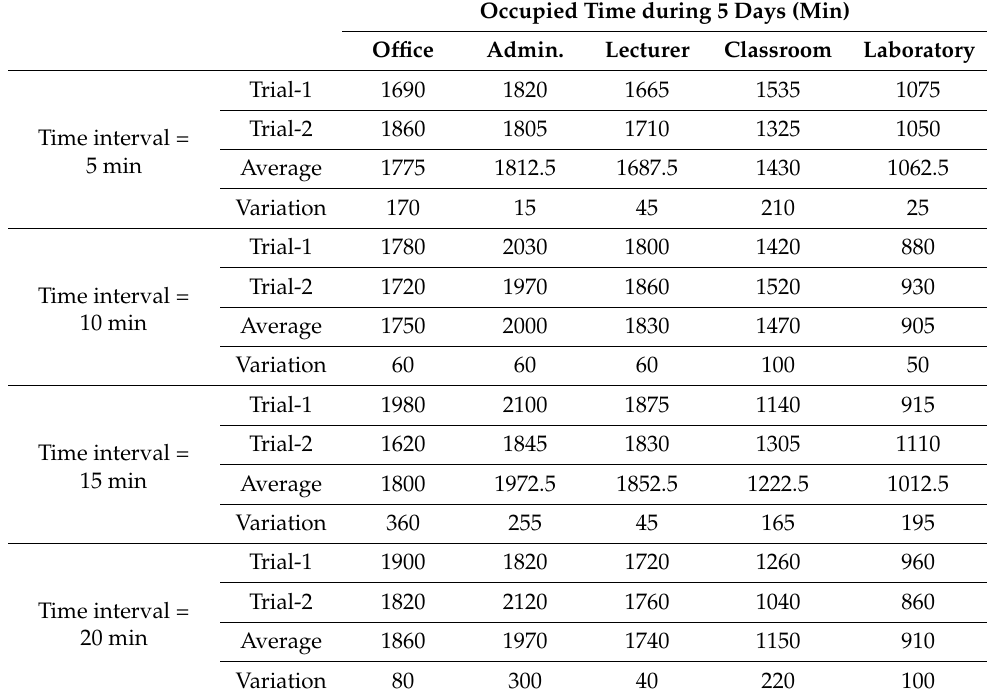
Table 5. Results of occupancy using different time